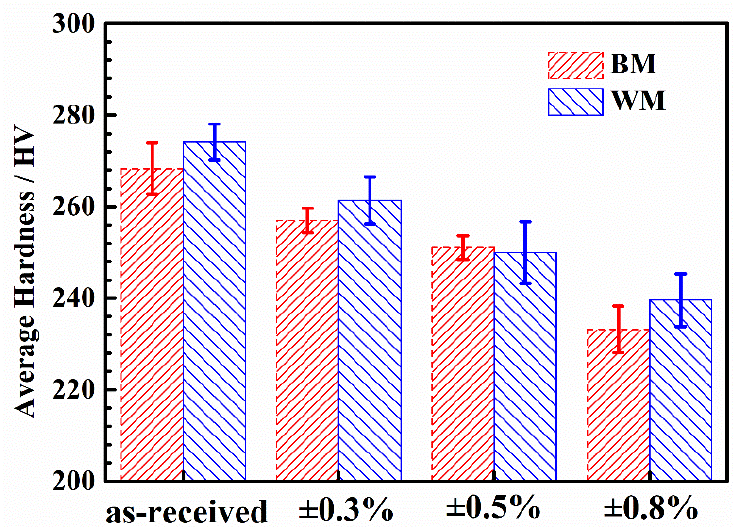
Figure 5. The average hardness of the as-received and low-cycle fatigue damaged BM and WM with different strain amplitudes.